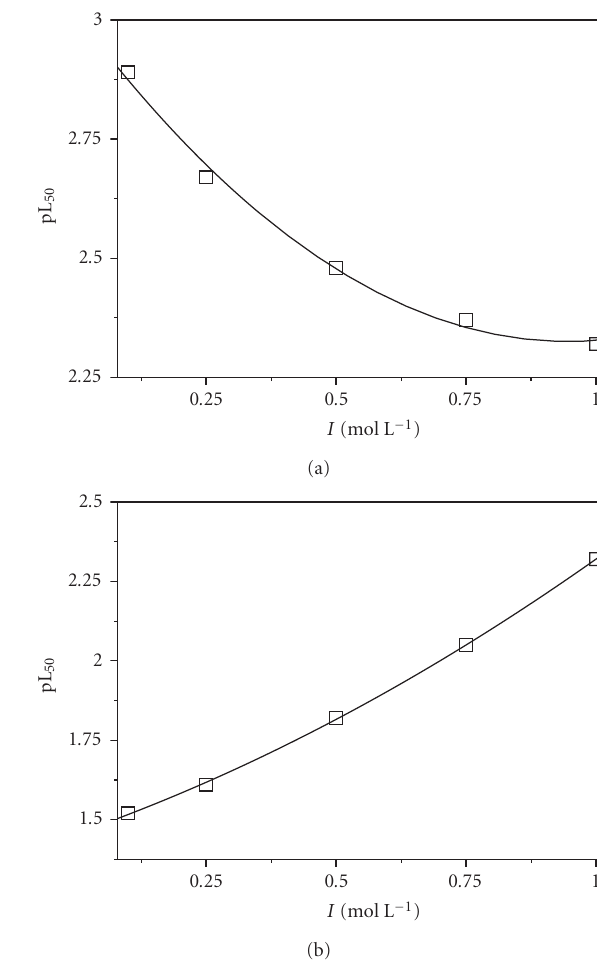
values for dmt sequestration 50